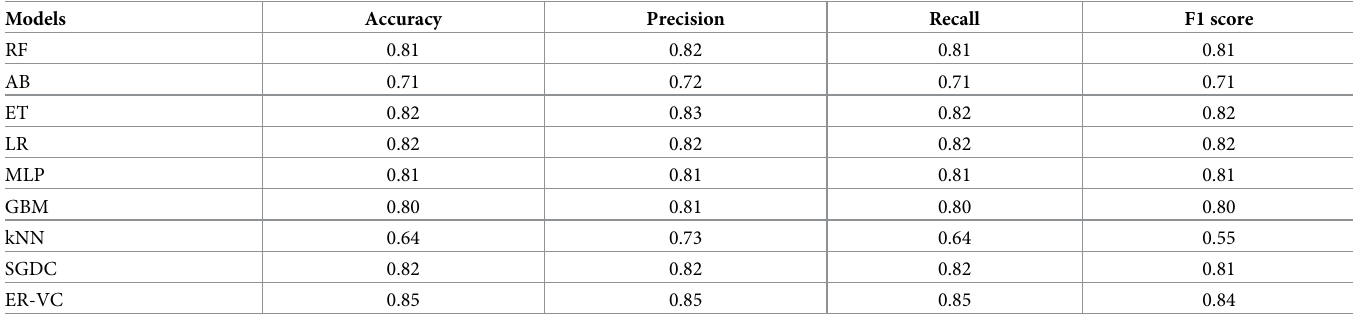
Table 6. Classification results of machine learning models using TF-IDF with SMOTE.